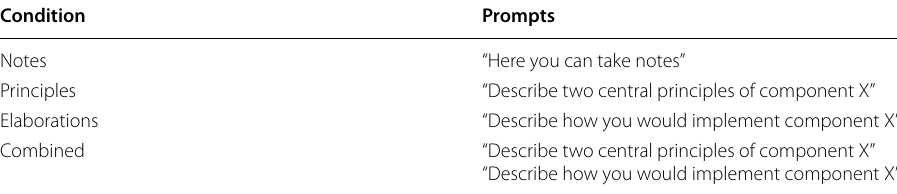
“X” is a placeholder for the respective component (a) modelling, (b) scaffolding and fading, (c) articulation and reflection, or (d) exploration